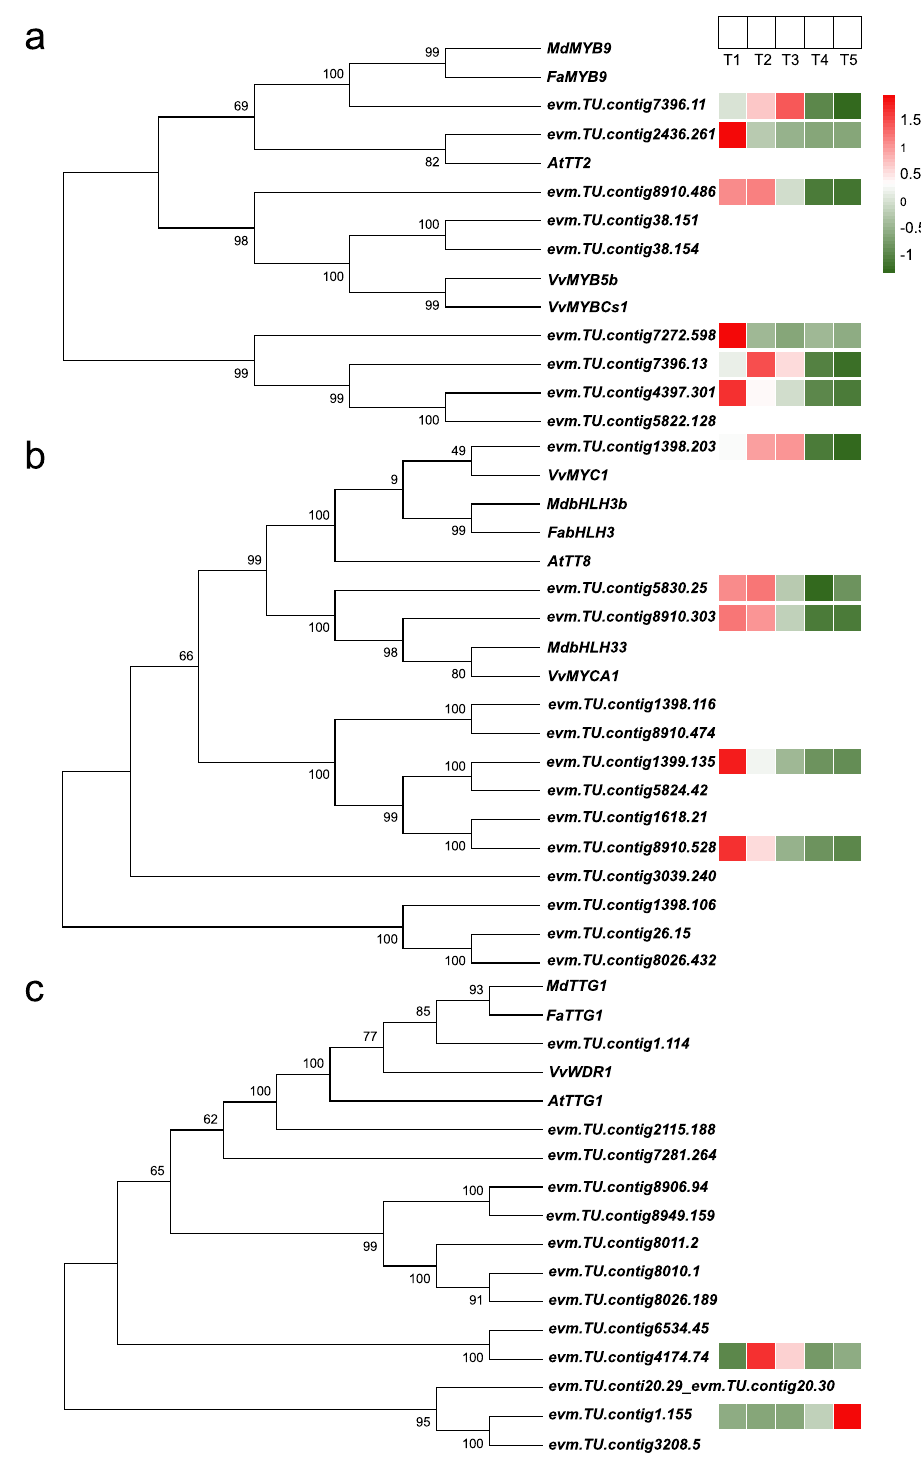
Figure 5. Phylogenetic trees of the MYB - bHLH - WD40 complex members in C-PCNA persimmon. ( a ) Phylogenetic tree of R2R3MYB , ( b ) phylogenetic tree of bHLH , and ( c ) phylogenetic tree of WD40 . Heat maps depict the normalized gene expression values, which represent the mean value of three biological